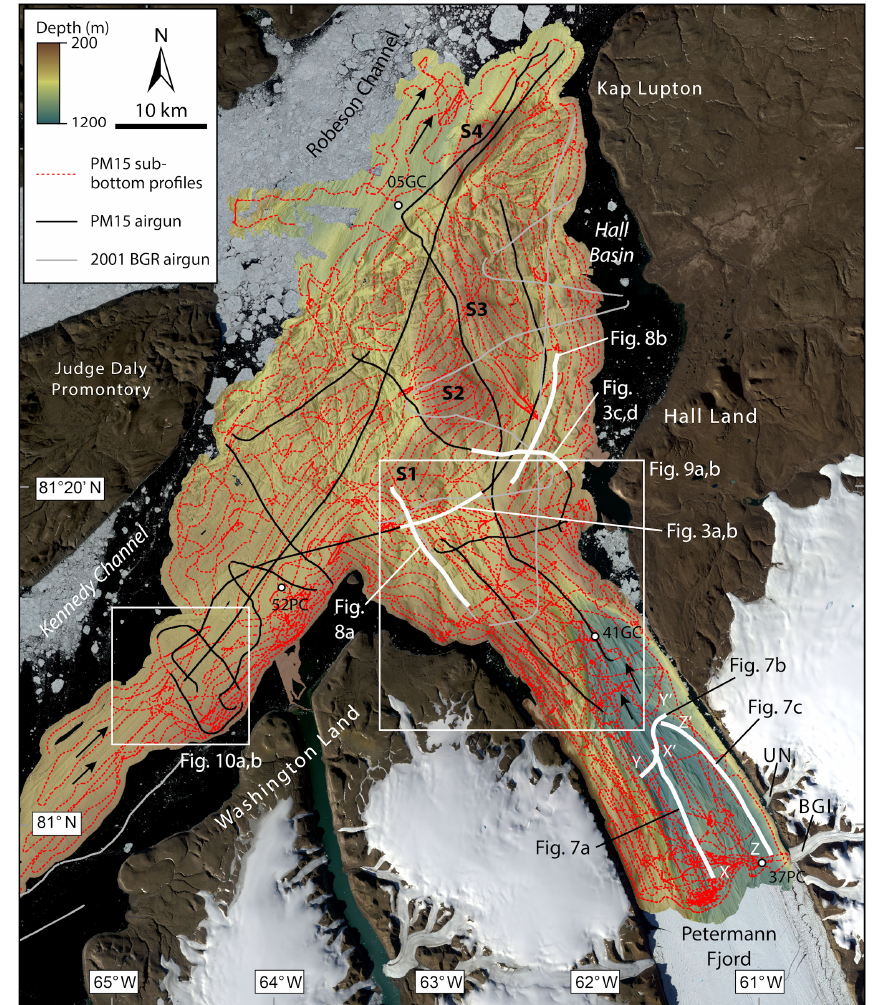
Figure 2. The locations of SBP profiles (red dashed), 2015 AG profiles (black) and 2001 legacy AG profiles (grey) shown over the gridded multibeam bathymetry for the area. S1–S4 are the bathymetric highs described by Jakobsson et al. (2018) and referred to in the text. UN is unnamed glacier; BGl is Belgrade Glacier. Glacial lineations denoting the former directions of ice flow are shown as black arrows (after Jakobsson et al., 2018). Sediment cores used to correlate seismo-acoustic facies with sediment lithofacies are also